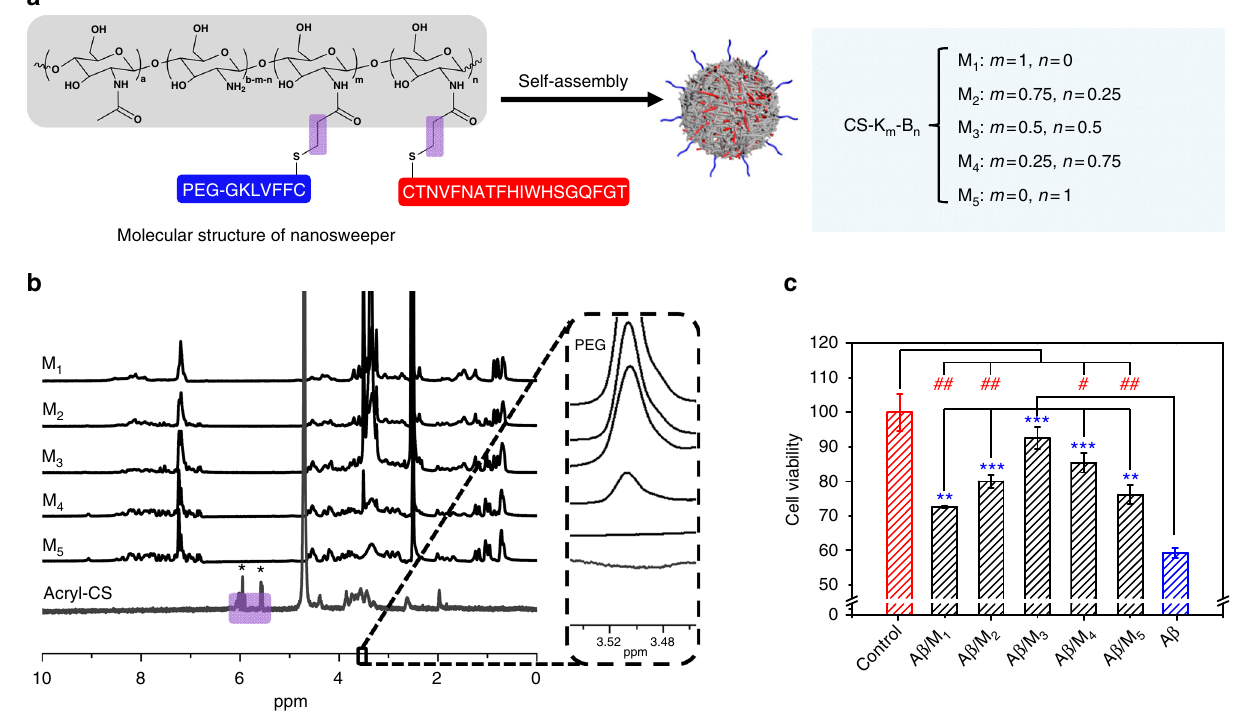
Fig. 2 The molecular structure and biological effect of M 3 in vitro. a Molecular structures of the multifunctional peptide-polymer M 1 – 5 , K and B were the abbreviation of HS-CFFVLKG-PEG (capture unit) and HS-CTNVFNATFHIWHSGQFGT (clearance unit), respectively. b The 1 H NMR of M 1 – 5 in 6 D-DMSO and acryl-CS in 6 D-H 2 O. c A β cytotoxicity (20 μ M) to N2a cells was reduced in the presence of 20 μ g·mL − 1 M 1 – 5 . Data are presented as mean ± standard deviation (s.d.) ( n = 3), analyzed by a Student ’ s t -test. Statistical signi fi cance is indicated as * p < 0.05, ** p < 0.01, and *** p < 0.001, for comparison with A β group, # p < 0.05, ## p < 0.01, and ### p < 0.001 for comparison with control